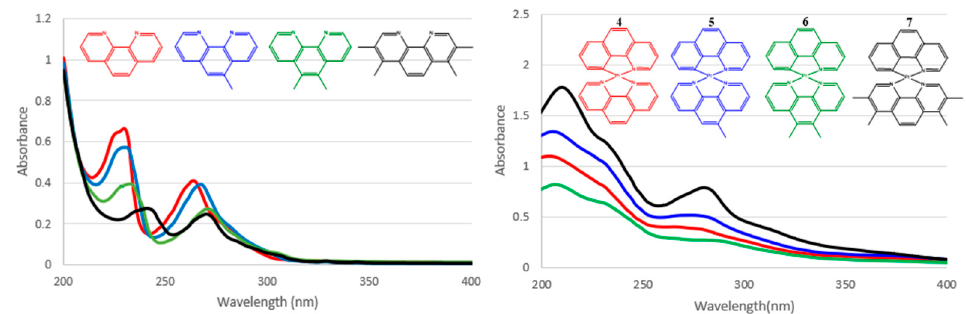
Figure 3. UV spectra of PHEN (red), 5MePHEN (blue), 56MePHEN (green), and TMP (black) at the same concentration in ethanol ( Left ) and UV spectra of 4 (red), 5 (blue), 6 (green), and 7 (black) at the same concentration in water ( Right ).